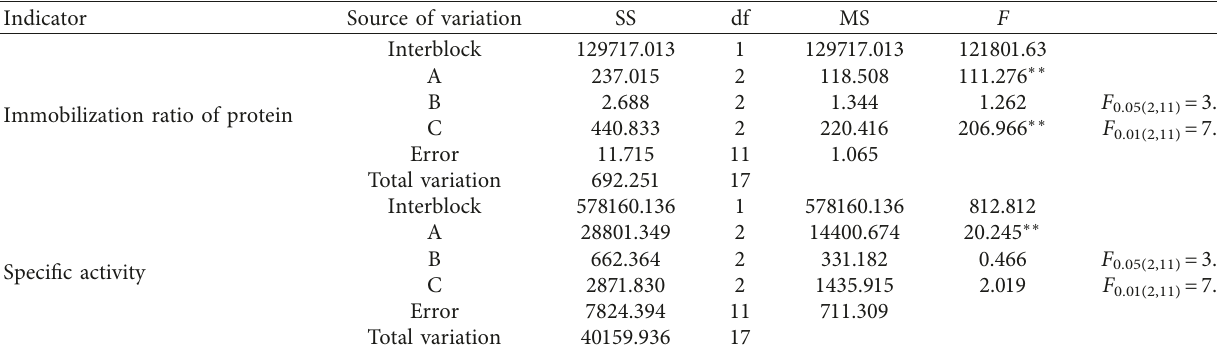
Table 3: Analysis of variance.